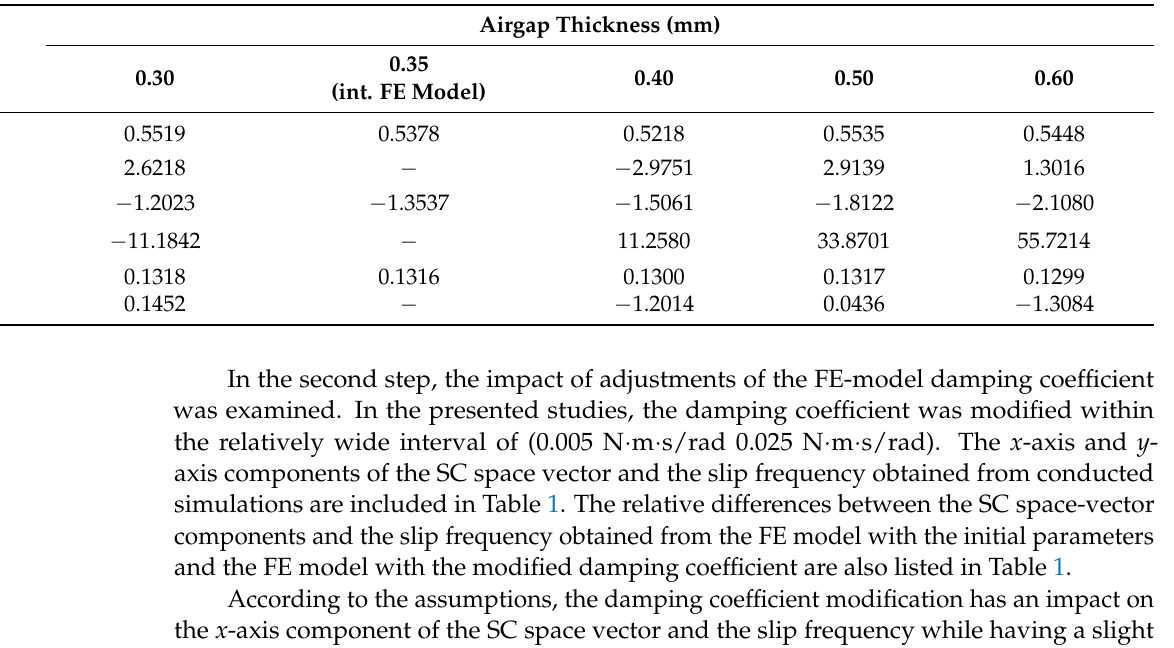
Table 3. The x -axis and y -axis components of the SC space vector and the slip frequency at the modification of the airgap thickness of the FE